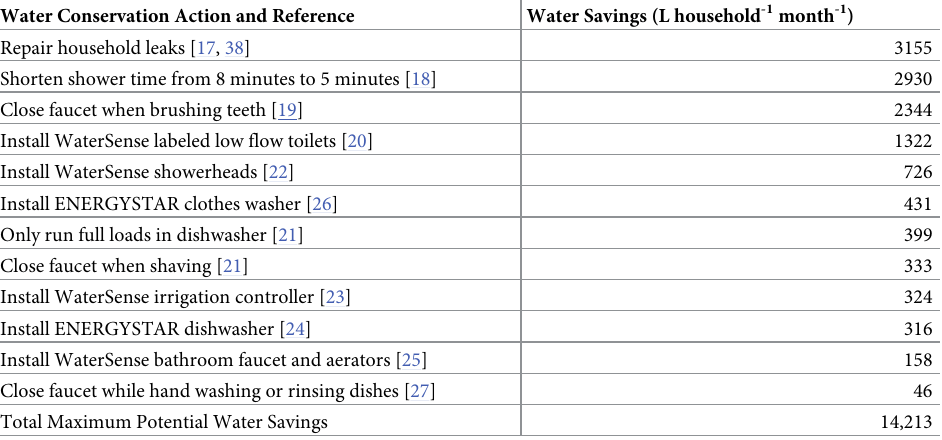
Table 1. Standardized potential monthly water savings per household from commonly promoted domestic water conservation